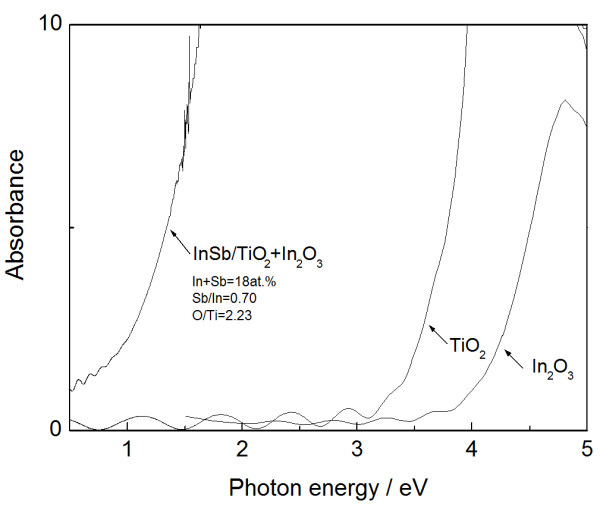
Typical optical absorption spectra of InSb-added TiO2 composite film. With a phase mixture of InSb, TiO2, and In2O3, containing 18 at.% (In + Sb).